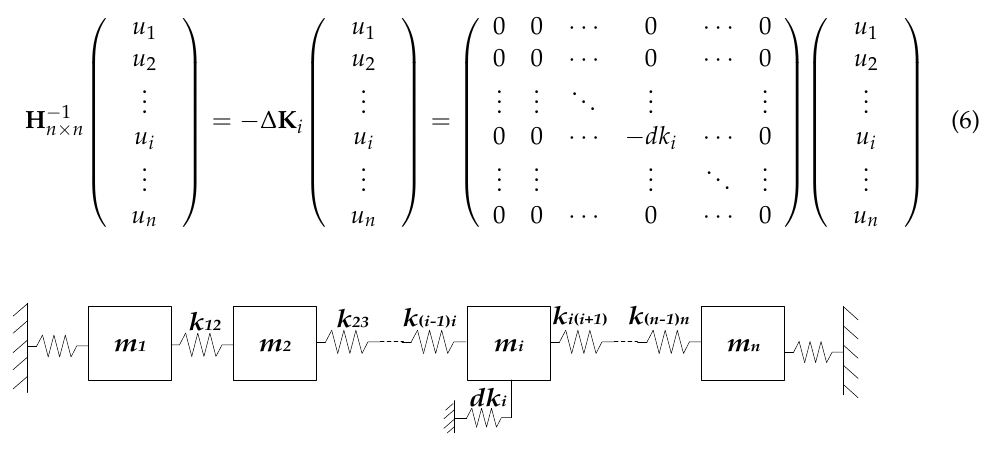
Figure 3. Structural modification by adding supporting stiffness.